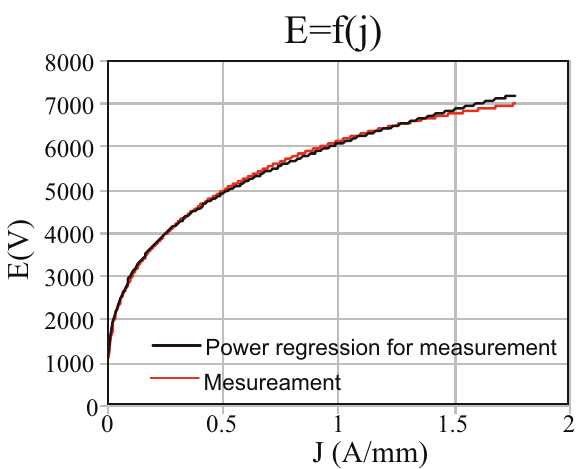
Figure 6: Electrical field as a function of current density in the semiconducting layer.